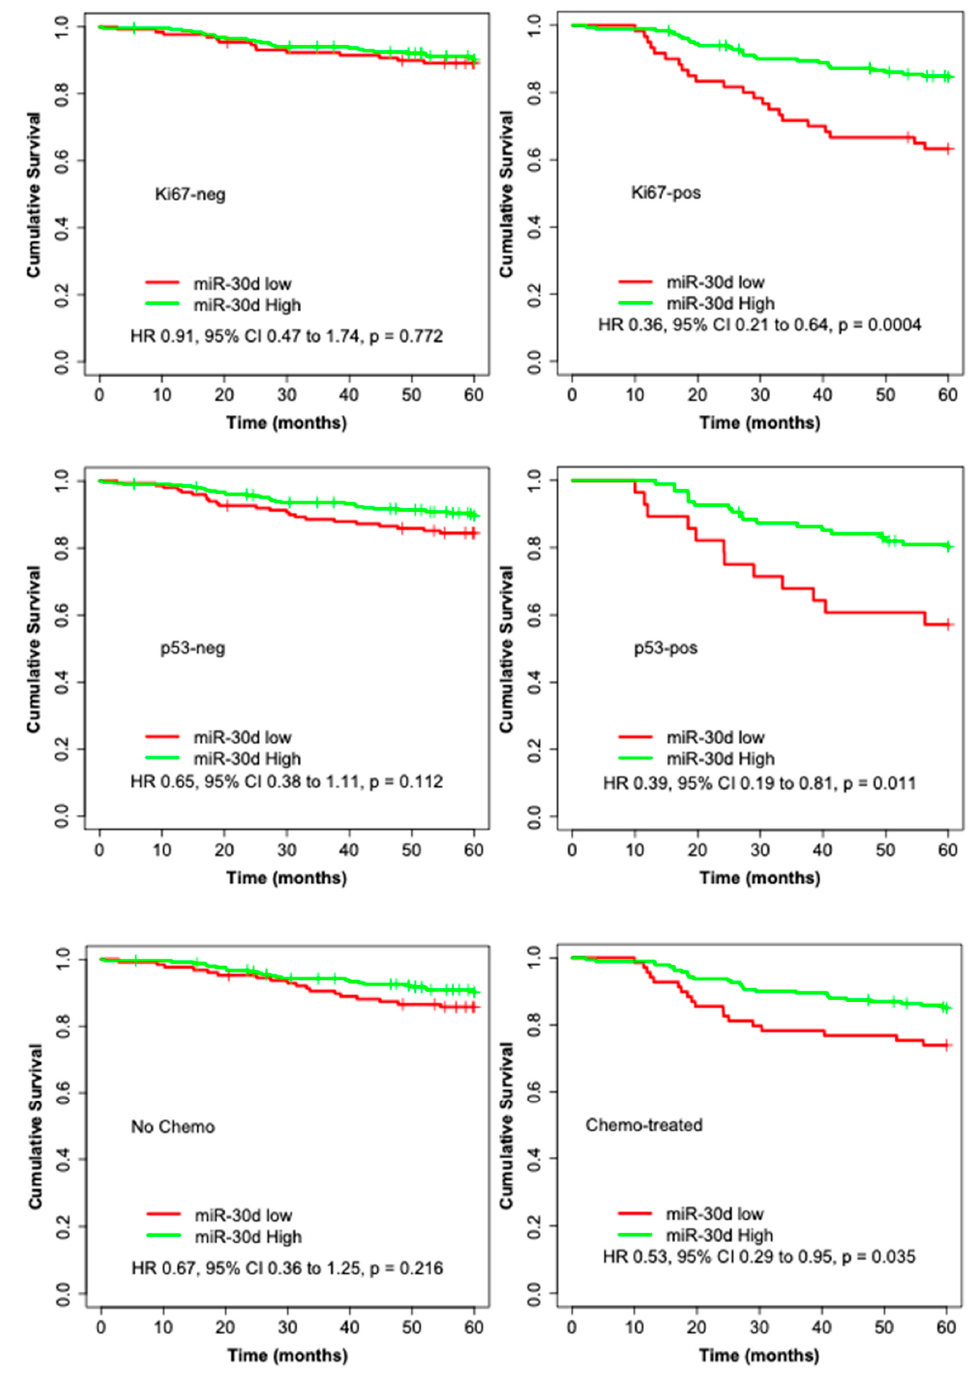
Figure 2. Kaplan–Meier curves illustrating the 5-year BDDM survival analyses by high and low expression of miR-30d for all patients and among the subgroups of: ER-negative, ER-positive, HER2-negative, HER2-positive, Ki67-negative, Ki67-positive, p53-negative, p53-positive, no chemotherapy, and chemotherapy-treated.